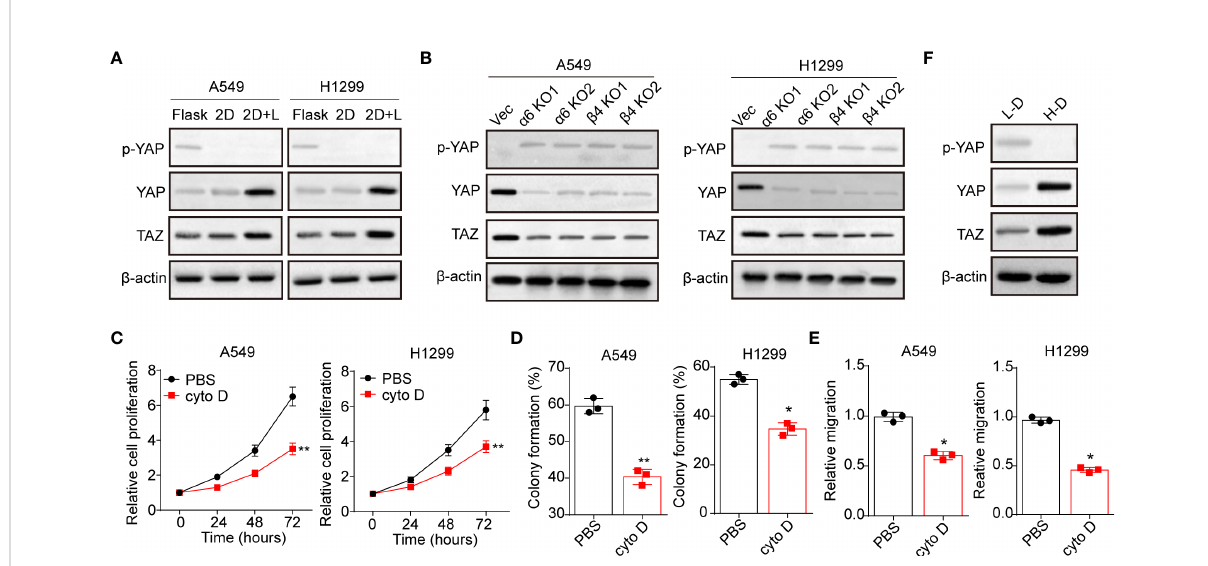
FIGURE 3 Laminin induced YAP/TAZ activation through integrin a 6 b 4. (A) , A549 and NCI-H1299 cells were cultured on fl ask, 2D collagen gels or 2D collagen gels containing laminin for 5 days. Then the expression of YAP, TAZ and phosphorylated YAP were assessed by western blotting. (B) , A549/NCI-H1299, integrin a 6 knockdown A549/NCI-H1299 and integrin b 4 knockdown A549/NCI-H1299 cells were cultured on 2D collagen gels containing laminin for 5 days. Then the expression of YAP, TAZ and phosphorylated YAP were examined by western blotting. (C) , A549 and NCI-H1299 cells were cultured on 2D collagen gels containing laminin for 5 days. Then the cells were cultured with PBS or cytochalasin (D) (1 m g/ml) and the cell proliferation was determined. D, the colony formation capability was assessed in tumor cells in (C) . (E) , the relative migration cells of tumor cells in (C) examined by transwell. (F) , western blotting of YAP, TAZ and phosphorylated YAP in high degree (H-D) and low degree (L-D) tumor tissues from NSCLC patients. *p < 0.05; **p <